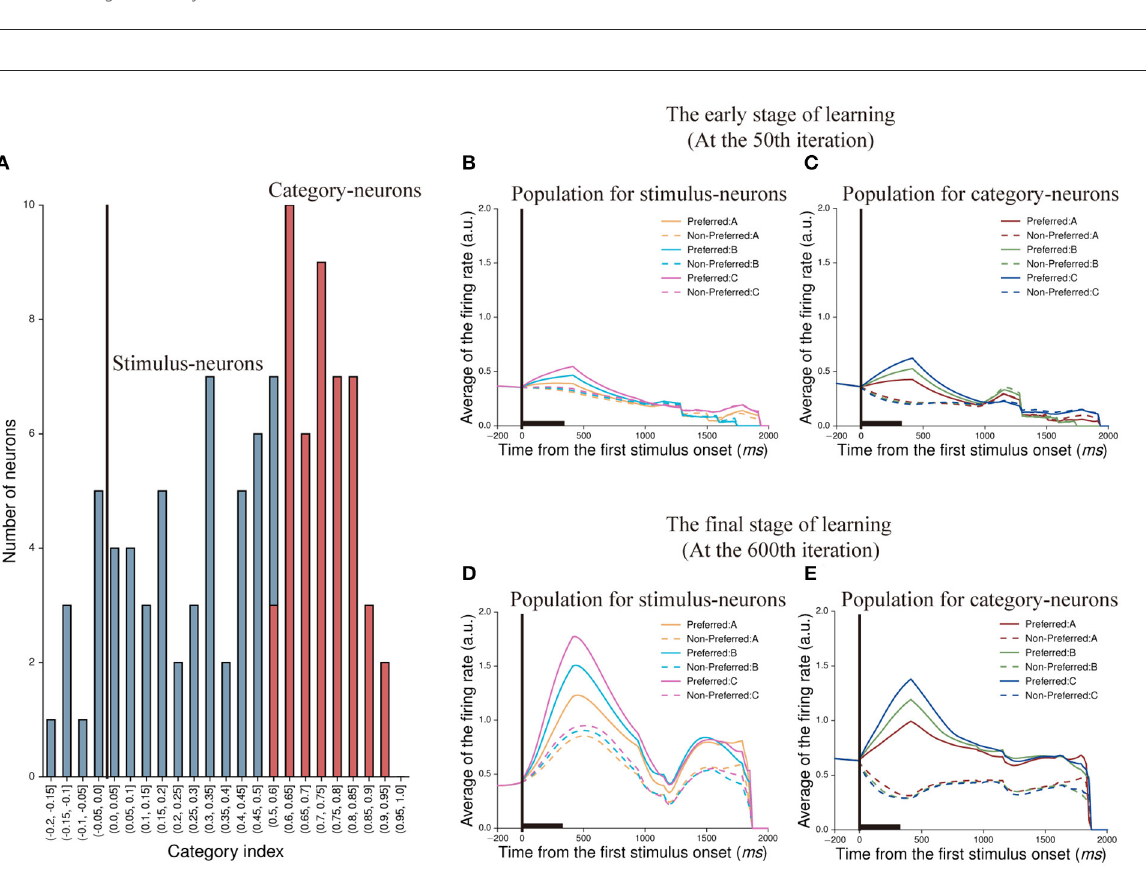
FIGURE5 Classification of neurons and their population activity at two learning stages. (A) The distribution of category indexes. Here, blue bars indicate 58 neurons whose category indexes are not significant ( p > 0.05, Bootstrap test), denoted as stimulus-neurons. And the range of category indexes for these neurons is from − 0.2 to 0.6. Red bars indicate 47 neurons whose category indexes are significant ( p < 0.05, Bootstrap test), denoted as category-neurons. And the range of category indexes for these neurons is from 0.5 to 1. (B,C) show population activity of stimulus-neurons (B) and category-neurons (C) in the early stage of learning (at the 50th iteration), respectively. The activity of each neuron is sorted by its preferred activity to the three paired stimuli (A1 vs. A2, B1 vs. B2, and C1 vs. C2) and then was averaged across neurons. (D,E) show population activity of stimulus-neurons (D) and category-neurons (E) in the final stage of learning (at the 600th iteration). The averaged firing rates shown in (B,D) are firing rates averaged across trials and across the stimulus-neurons. The averaged firing rates shown in (C,E) are firing rates averaged across trials and across